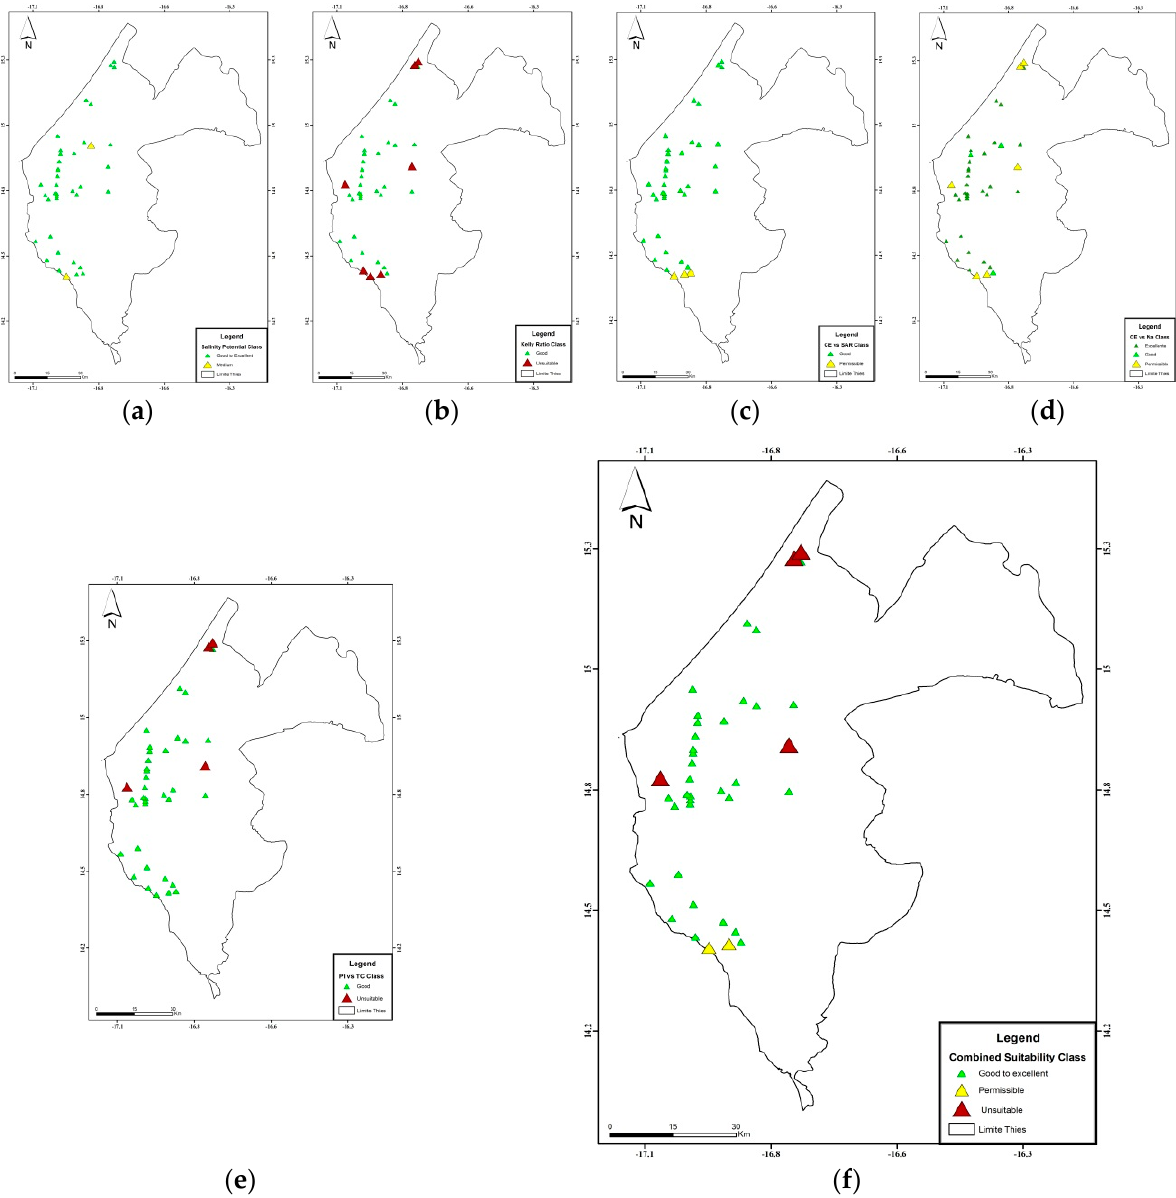
Figure 7. Salinity potential ( a ), Kelly ratio ( b ), CE vs. SAR ( c ), CE vs. Na% ( d ), PI vs. TC ( e ), and combined ( f ) suitability maps of Maastrichtian aquifer for irrigation purpose.